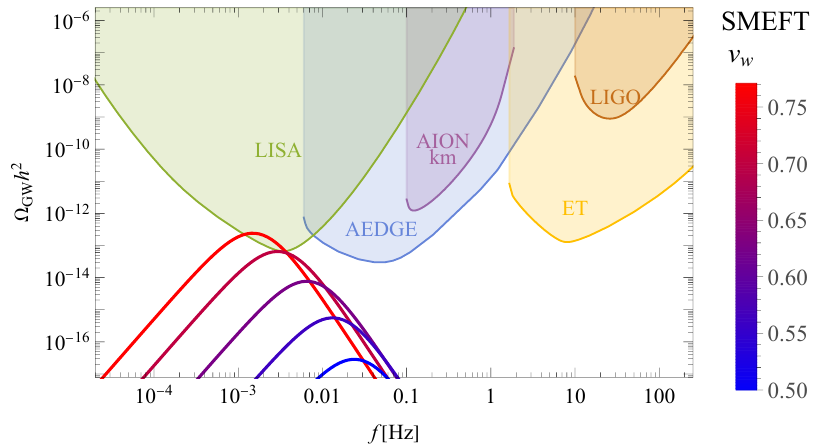
Figure 14 . Gravitational wave signals for a range of parameters starting with the strongest transi- tions in the SMEFT model together with power-law integrated sensitivities of current and upcoming experiments.